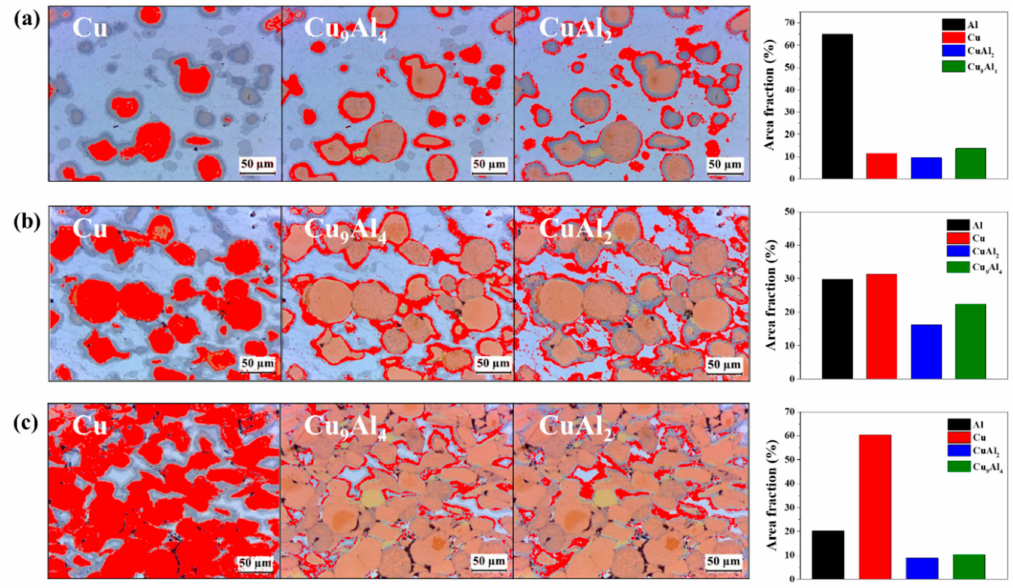
Figure 6. Area fractions of Al, Cu, Cu 9 Al 4 , and CuAl 2 obtained using image analysis software ImageJ: ( a ) Al–20Cu, ( b ) Al–50Cu, and ( c )